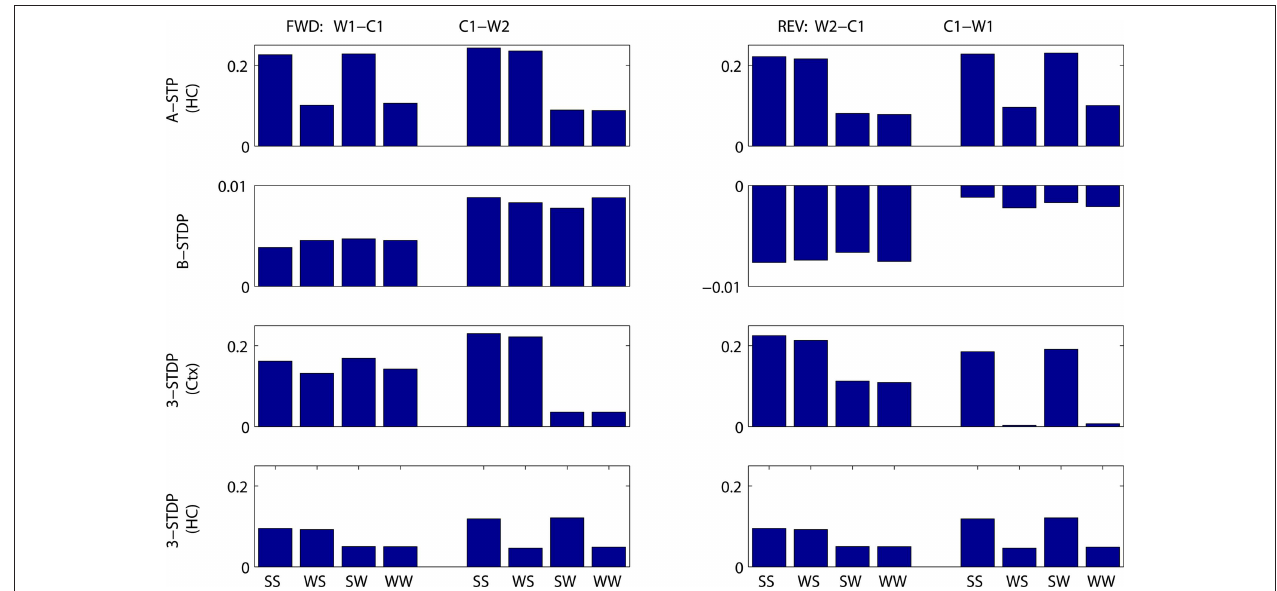
word to context-1. C1–W1 = context-1 to first word. Stimulus protocols are both strong (SS), weak then strong (WS), strong then weak (SW) or both weak (WW). Top row: associative short-term plasticity (ASTP). Second row: basic STDP. Third row: triplet-STDP (3-STDP) with parameters from cortical data (Ctx). Fourth row: